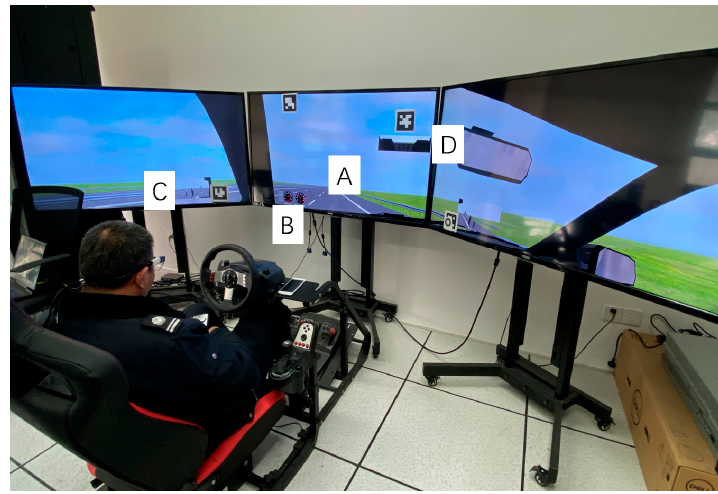
Figure 2. Visual inspection areas include: ( A ) road ahead; ( B ) dashboard; ( C ) left rearview mirror; ( D ) central rearview mirror.